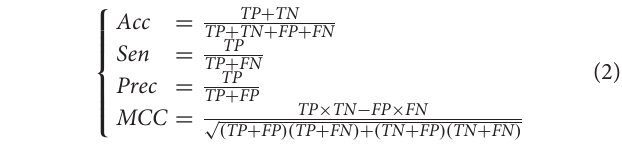
Frontiers in Genetics |